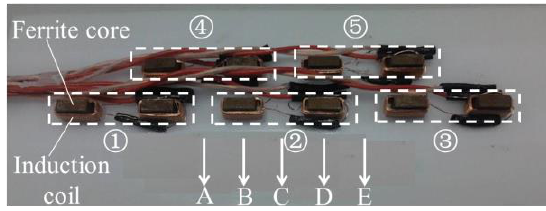
Figure 10. The sensor array in the lift-off-tolerant MFL probe in two layers.